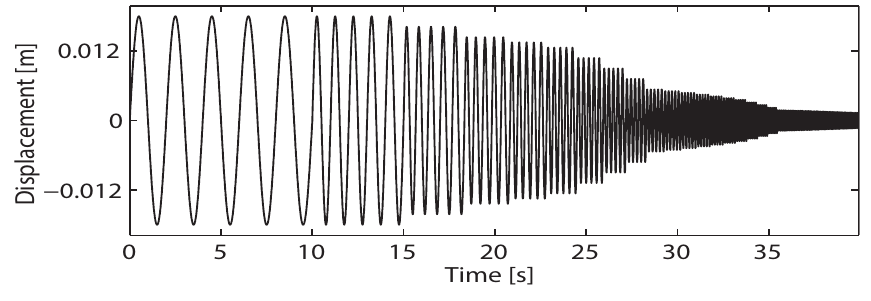
Figure 10. Frequency domain input signal. Table 10. Definition of the relative amplitude